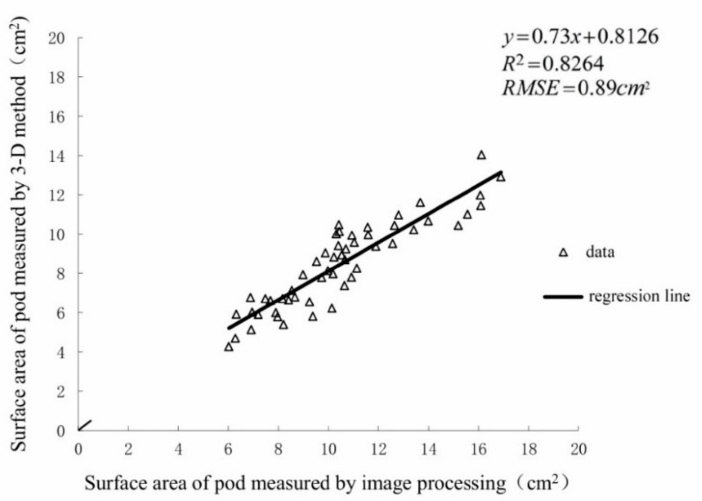
Figure 9. Correction model established by image processing method and the 3-D method. The range of the pod surface area was measured as 6.03–16.89 cm 2